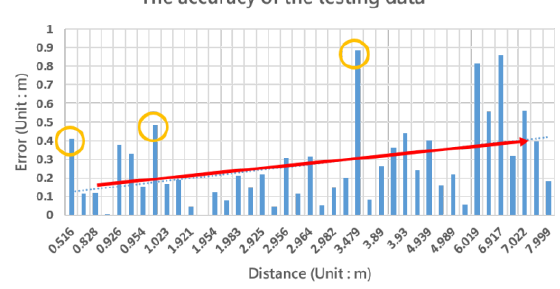
Figure10. the accuracy of the testing data